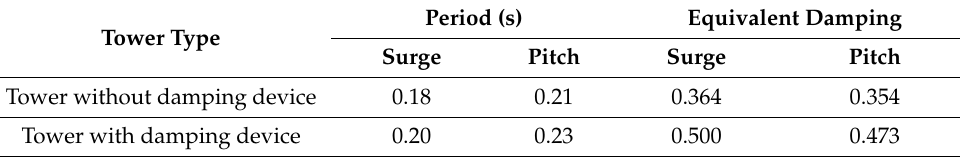
Figure 15. Natural vibration attenuation curve of the tower with the damping device. Table 5. The natural vibration period and equivalent damping of the two towers.